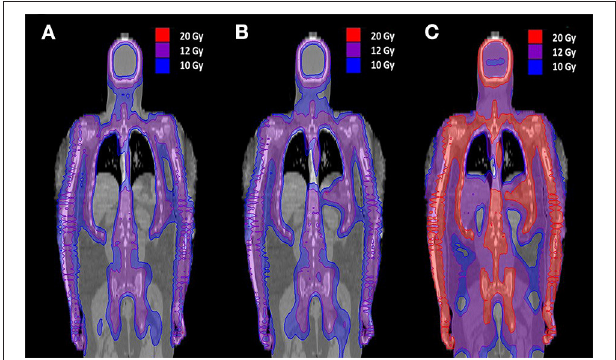
FIGURE 4 | Radiation dose distribution in the coronal plane of TMI and TMLI with different TMI/TMLI approaches. (A) Total marrow irradiation (TMI) of 12Gy to the bone marrow. (B) Total marrow and lymphoid irradiation (TMLI) of 12Gy to bone marrow and the lymph nodes. (C) TMLI of 20Gy to the bone, spleen, and lymph node chains, with a liver and brain prescription dose to 12Gy. The isofill-depicted dose levels are 10Gy (blue), 12Gy (purple), and 20Gy